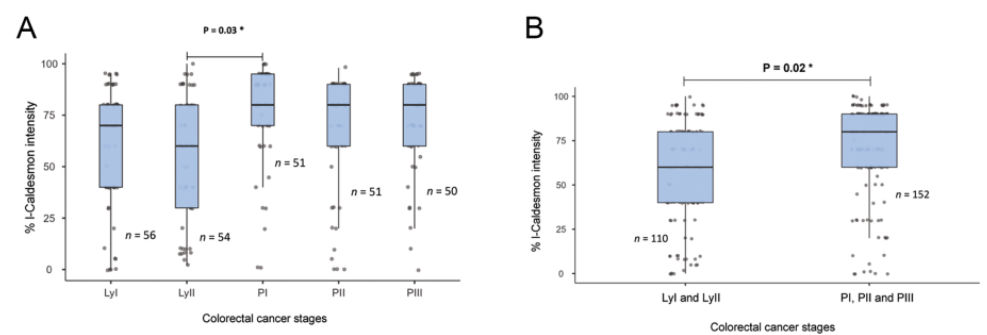
Figure 2. Relationship between l-CaD expression and colorectal cancer tumor stage. ( A ) l-CaD ex- pression by detailed tumor stage; ( B ) l-Cad expression by grouped tumor stage showing a significant relationship between l-CaD and primary tumor stage. Ly, lymph node stage; PI-III, primary tumor stages I-III; * p <